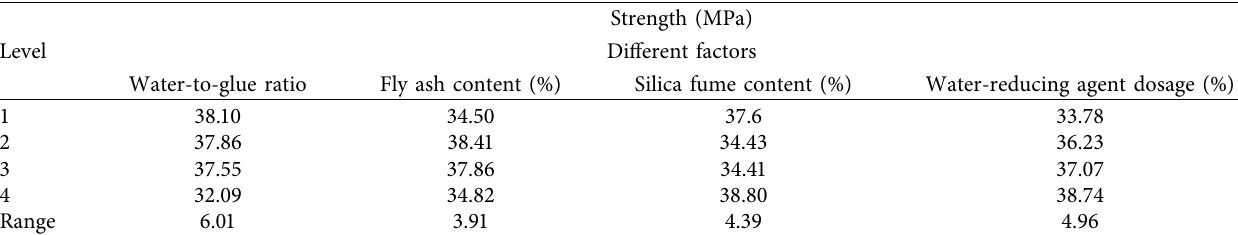
Table 3: Range analysis of 7-day compressive strength of concrete.